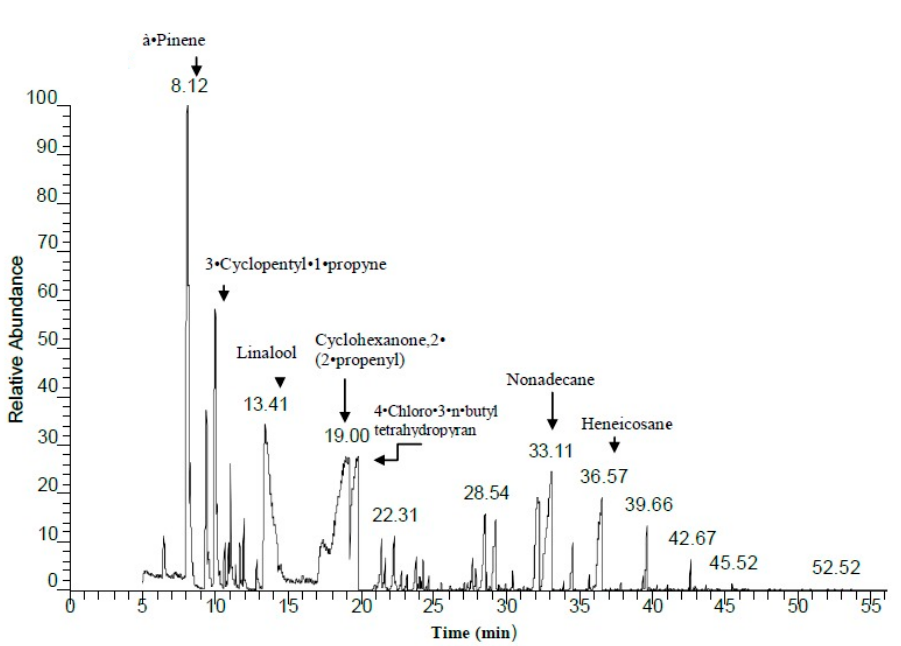
Figure 2. Representative sample of the GC-MS fingerprints generated by GC-MS analysis of the studied rose oils. Table 2. Example of GC–MS data of rose oil composition. RT = retention time, MW = molecular weight, MF = molecular formula. Area% = the percentage of the component.